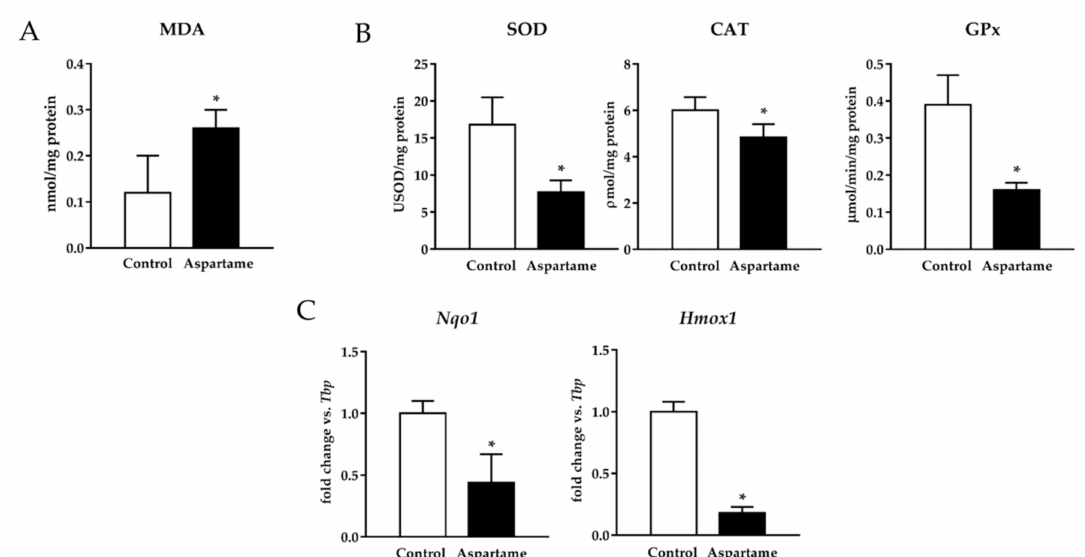
Figure 3. Malondialdehyde (MDA) levels were measured in the livers of control and aspartame-treated mice ( n = 6, each group) ( A ). The activity of antioxidant enzymes superoxide dismutase (SOD), catalase (CAT), and glutathione peroxidase (GPx) measured by spectrophotometry in the livers of control and aspartame-treated mice ( n = 6, each group) ( B ). mRNA relative expression of NADPH quinone oxidoreductase 1 ( Nqo1 ) and heme oxygenase 1 ( Hmox1 ) versus Tbp measured by RT-qPCR in the livers of control and aspartame-treated mice ( n = 6, each group) ( C ). The statistical difference is indicated as follows: * p < 0.05 versus